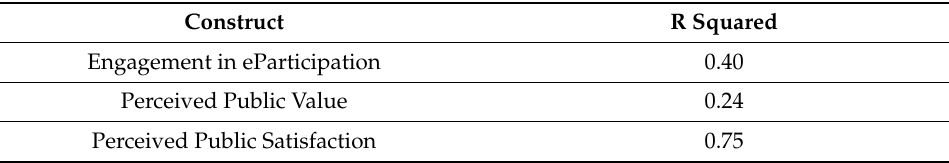
Table 5. Coefficient of determination (R 2 ) values.